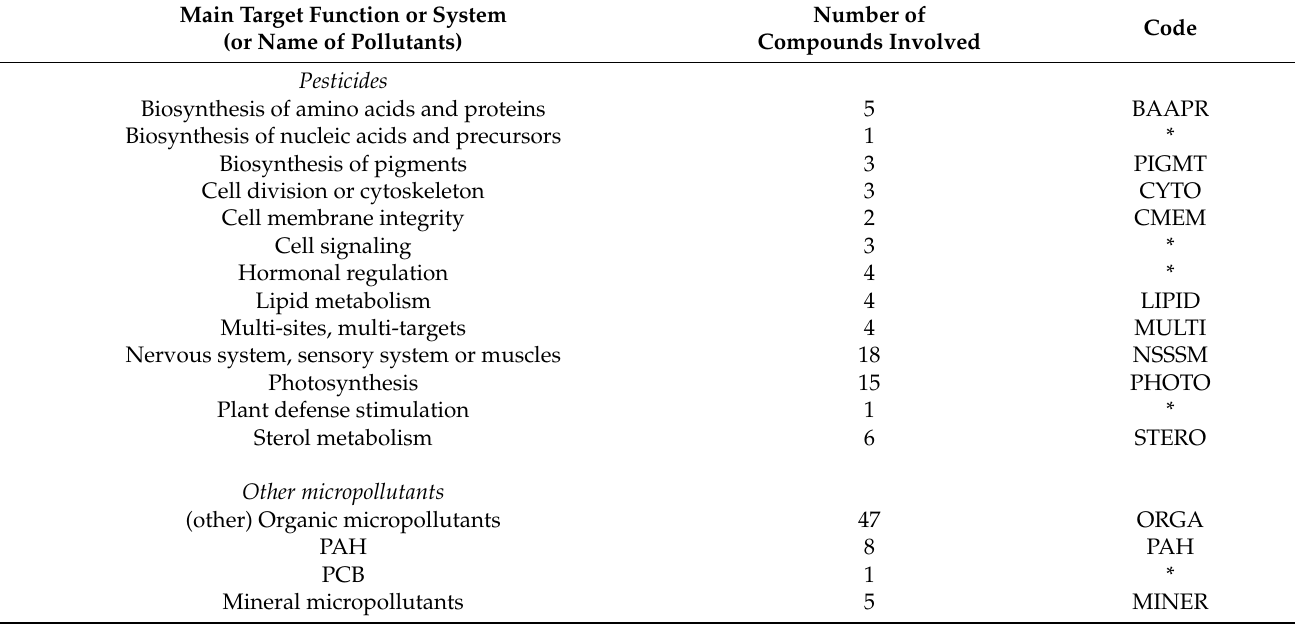
Table 1. Main functions targeted by pesticides when referring to the R4P database. When the mode of action has not been identified (i.e., for the other micropollutant types), only the name of the pollutant type is given. For each, the total number of compounds (or compound families) involved and their codes for downstream analyses are provided. In the right column, a star (*) indicates the types of functions (or micropollutants) that were not kept in the following analyses (see the end of Section 2.2 for more details about the selection